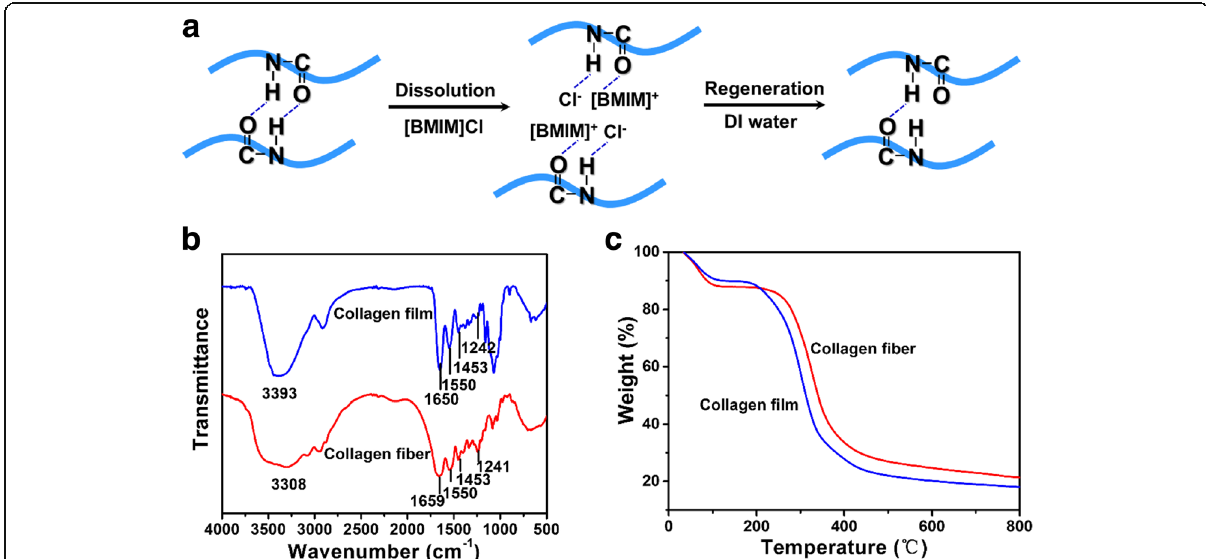
Fig. 1 Properties of collagen fibers. a Dissolution and regeneration mechanism of collagen fibers. b FT-IR spectra of collagen fibers and collagen films. c TGA profiles of collagen fibers and collagen films (10 °C min − 1 ramp, N 2